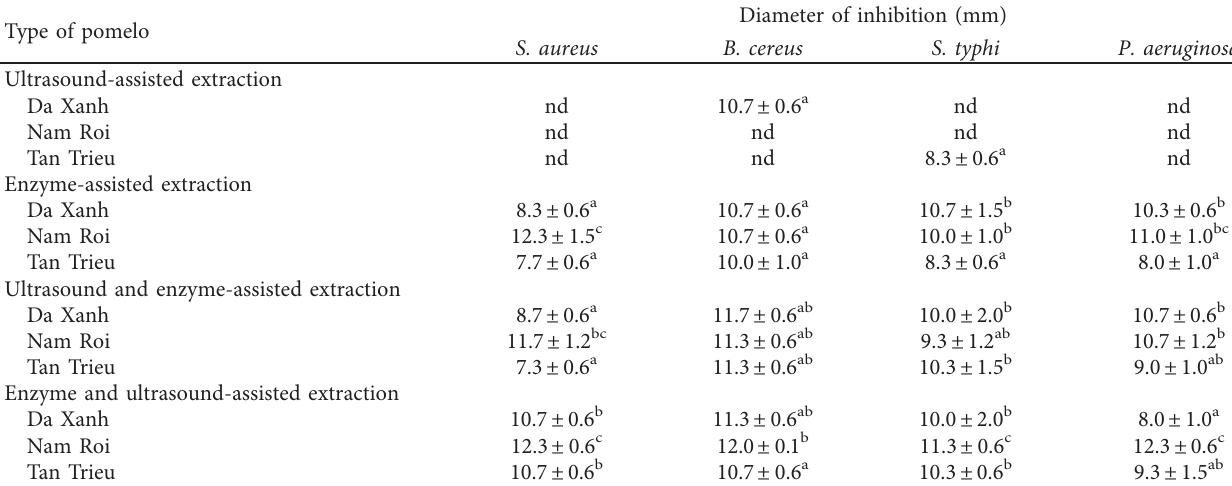
Table 3: Antimicrobial activities of extracts from pomelo peels using different extraction methods 1 . Type of